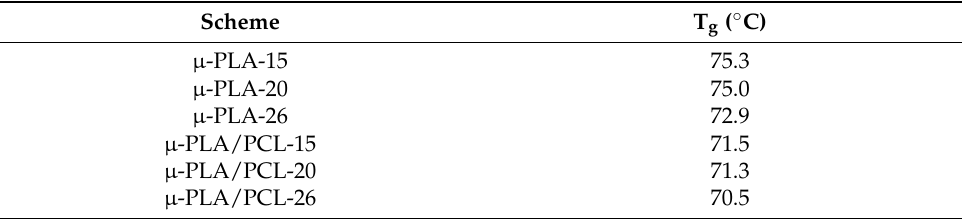
Table 5. The glass transition temperature (T g ) of pure polylactic acid (PLA) and PLA/PCL blend micropart with different cavity size in DMA